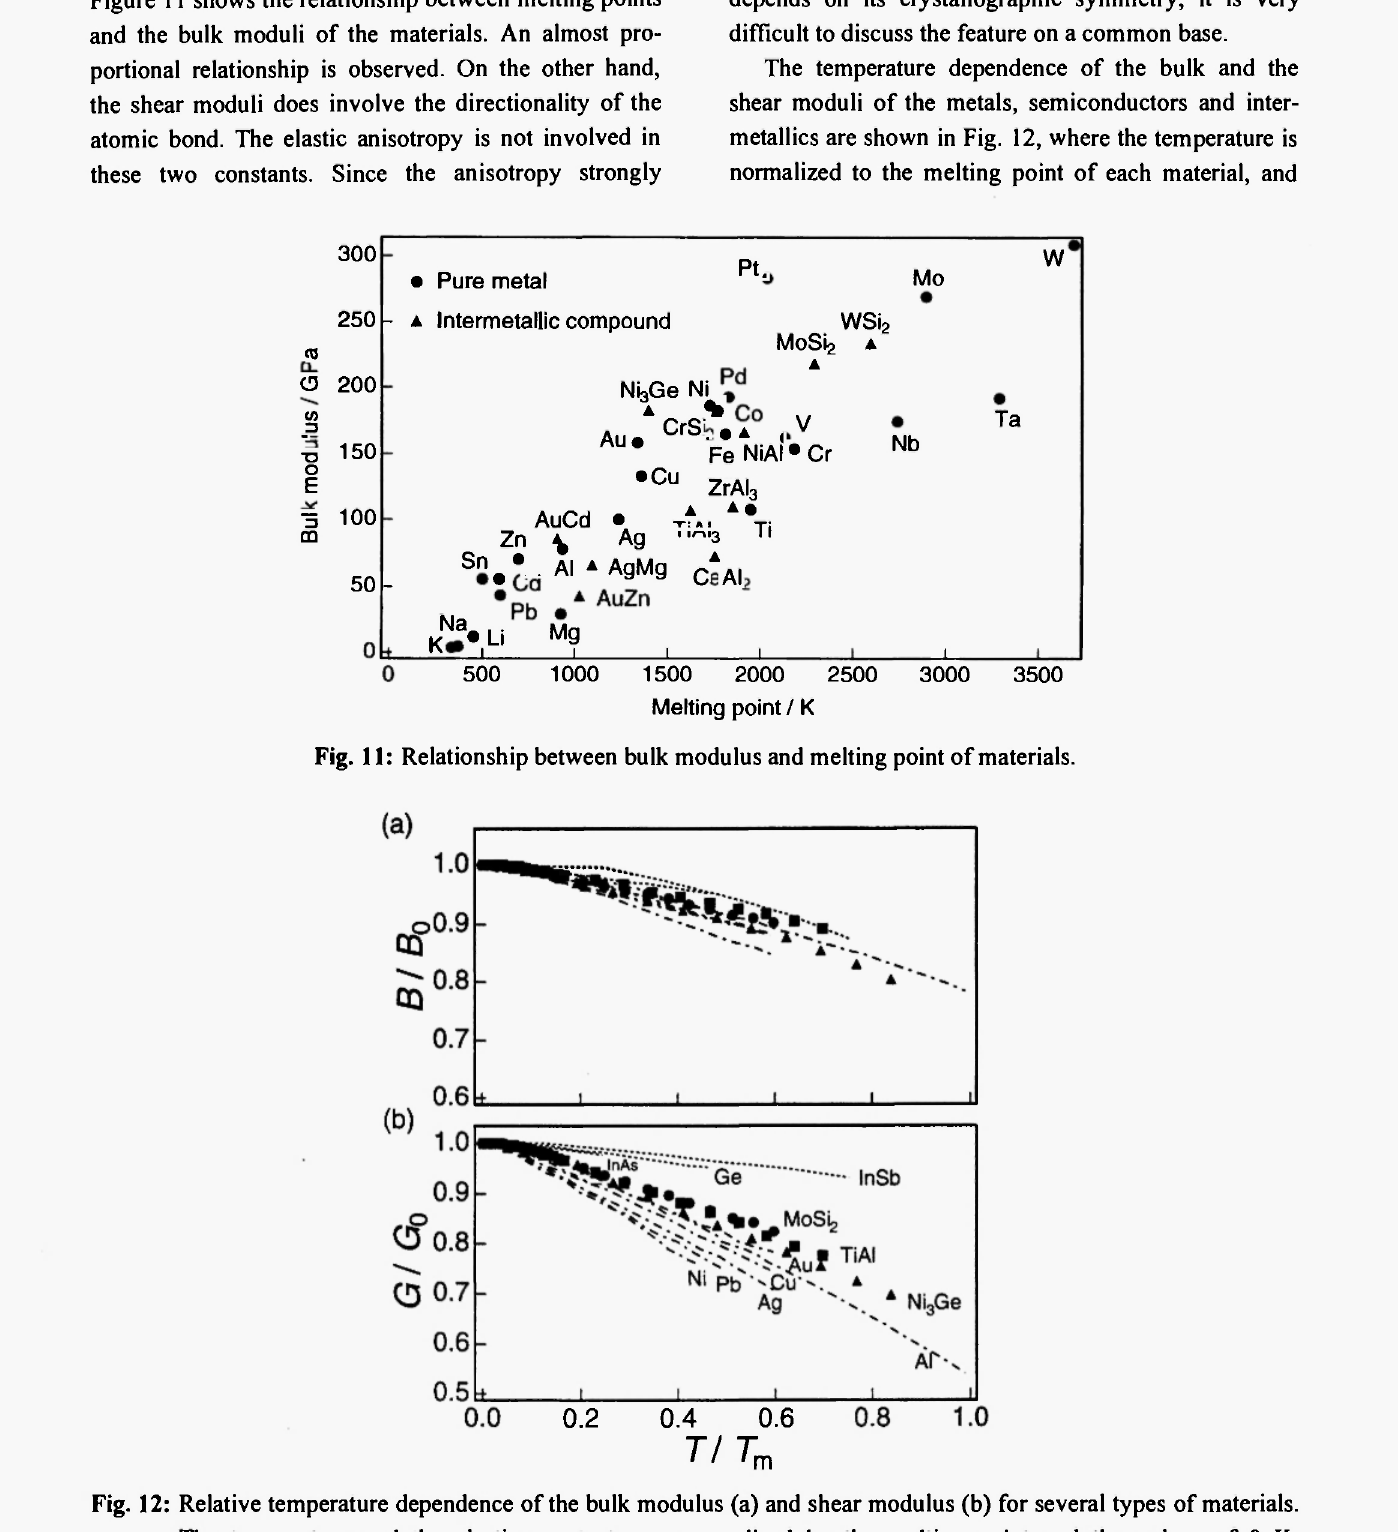
Fig. 11 : Relationship between bulk modulus and melting point of materials.